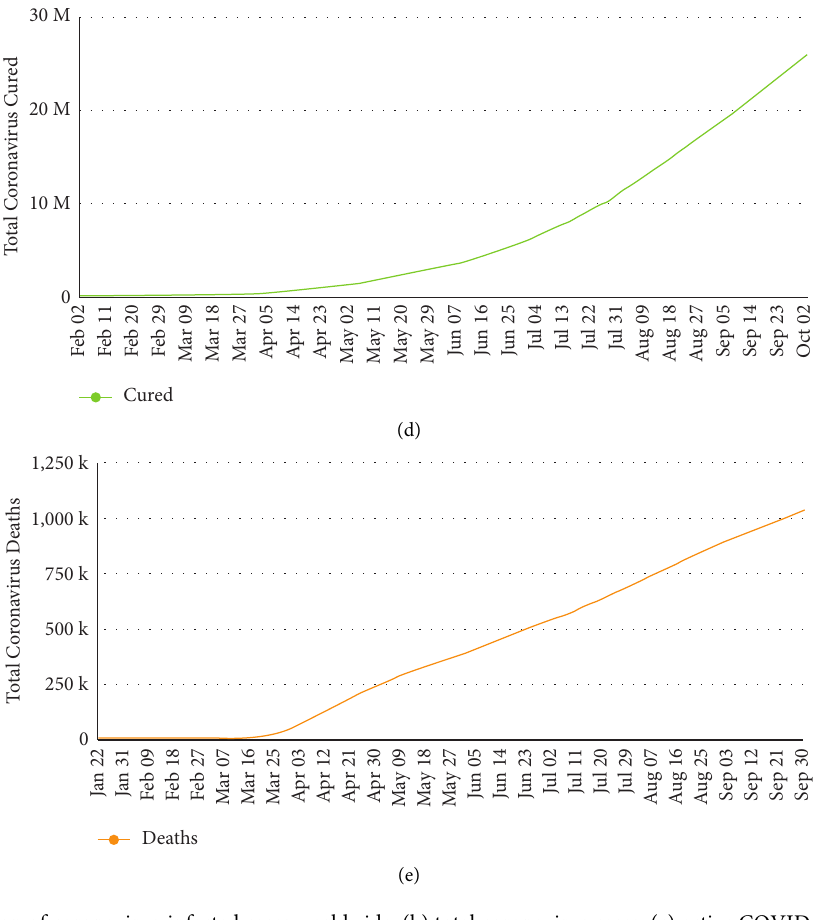
Figure 1: (a) Distribution of coronavirus-infected cases worldwide, (b) total coronavirus cases, (c) active COVID-19 cases, (d) total cured cases, and (e) total COVID-19